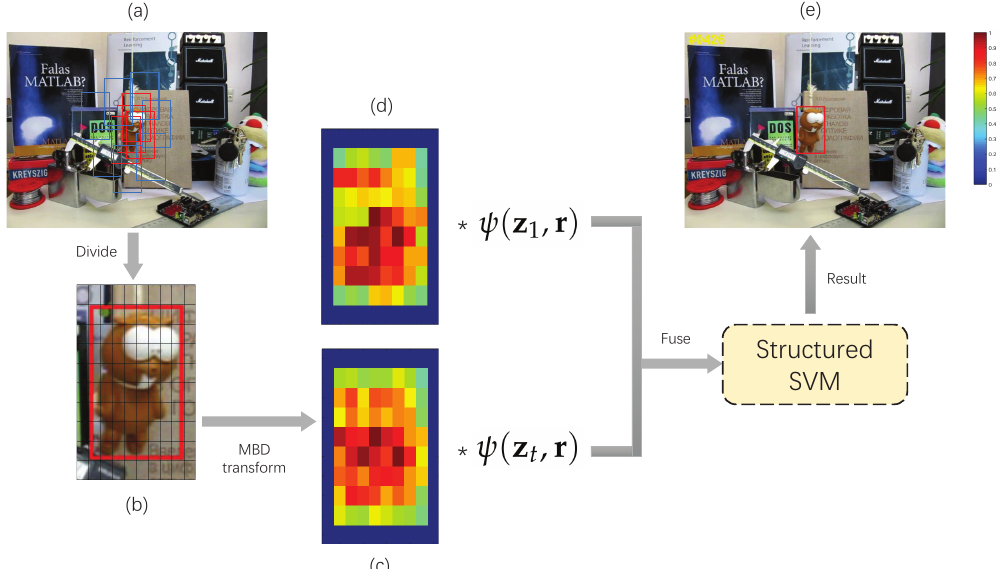
Figure 2. The pipeline of our proposed algorithm. ( a ) A frame with some candidate bounding boxes in a search region around the position from the previous frame. ( b ) An extended bounding box and the bounding box shown in red. ( c ) The minimum barrier distance (MBD) map of the bounding box in the current frame. The MBD of boundary patches in the extended bounding box is set to 0 (the dark blue area) because they are seeds. ( d ) The MBD map of the bounding box in the first frame. ( e ) The bounding box obtained by our tracker. Structured support vector machine (SVM) is learned online to provide adaptive